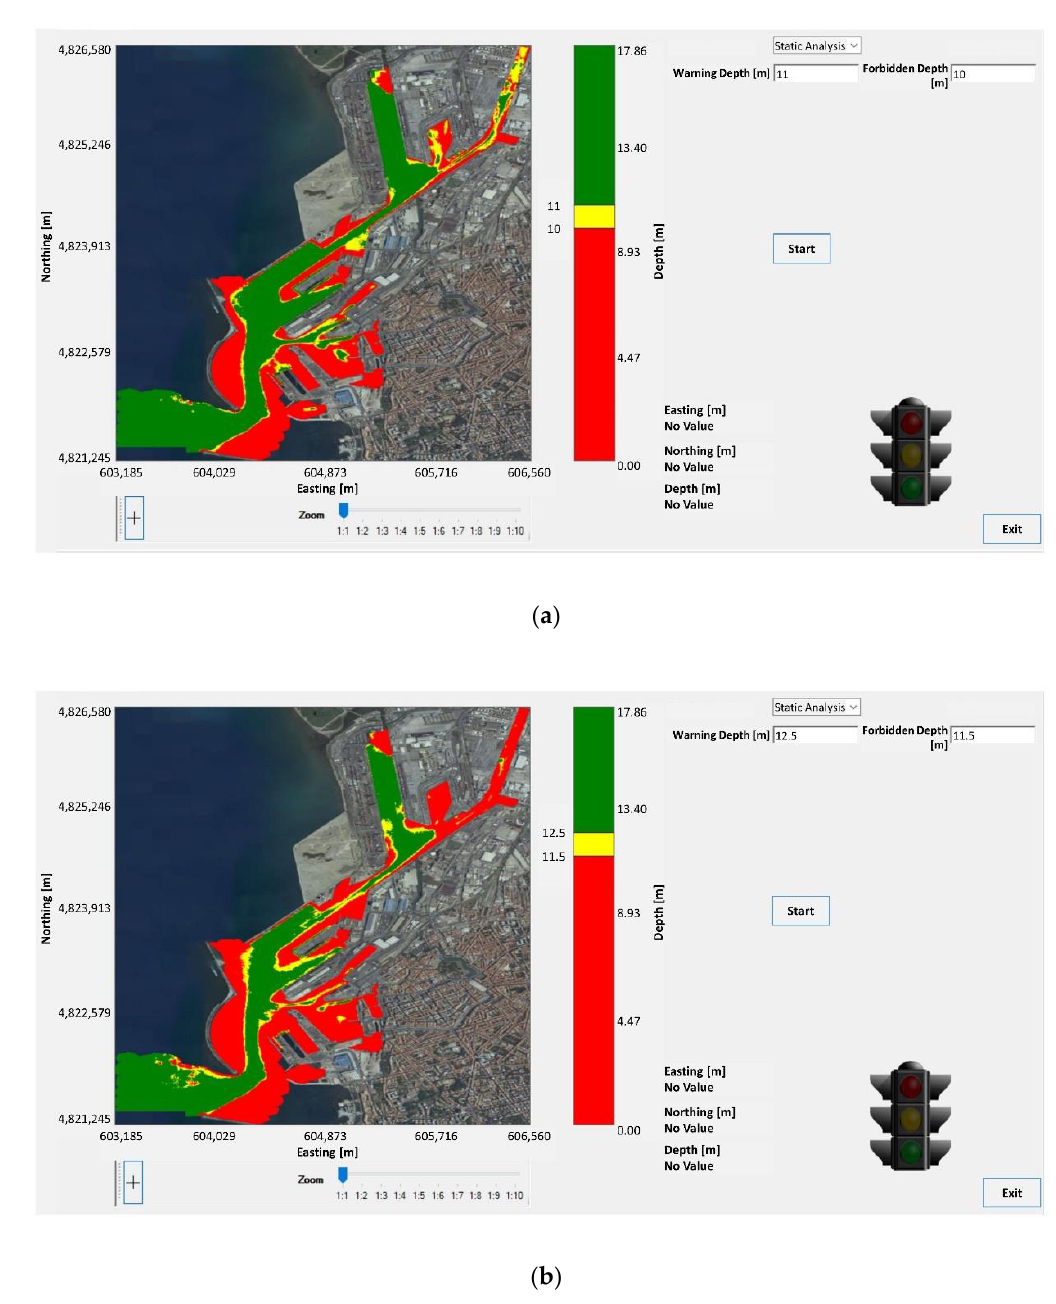
Figure 3. Virtual traffic lights in the port of Livorno: ( a ) thresholds equal to 10 and 11 m; ( b ) thresholds equal to 11.5 and 12.5 m.